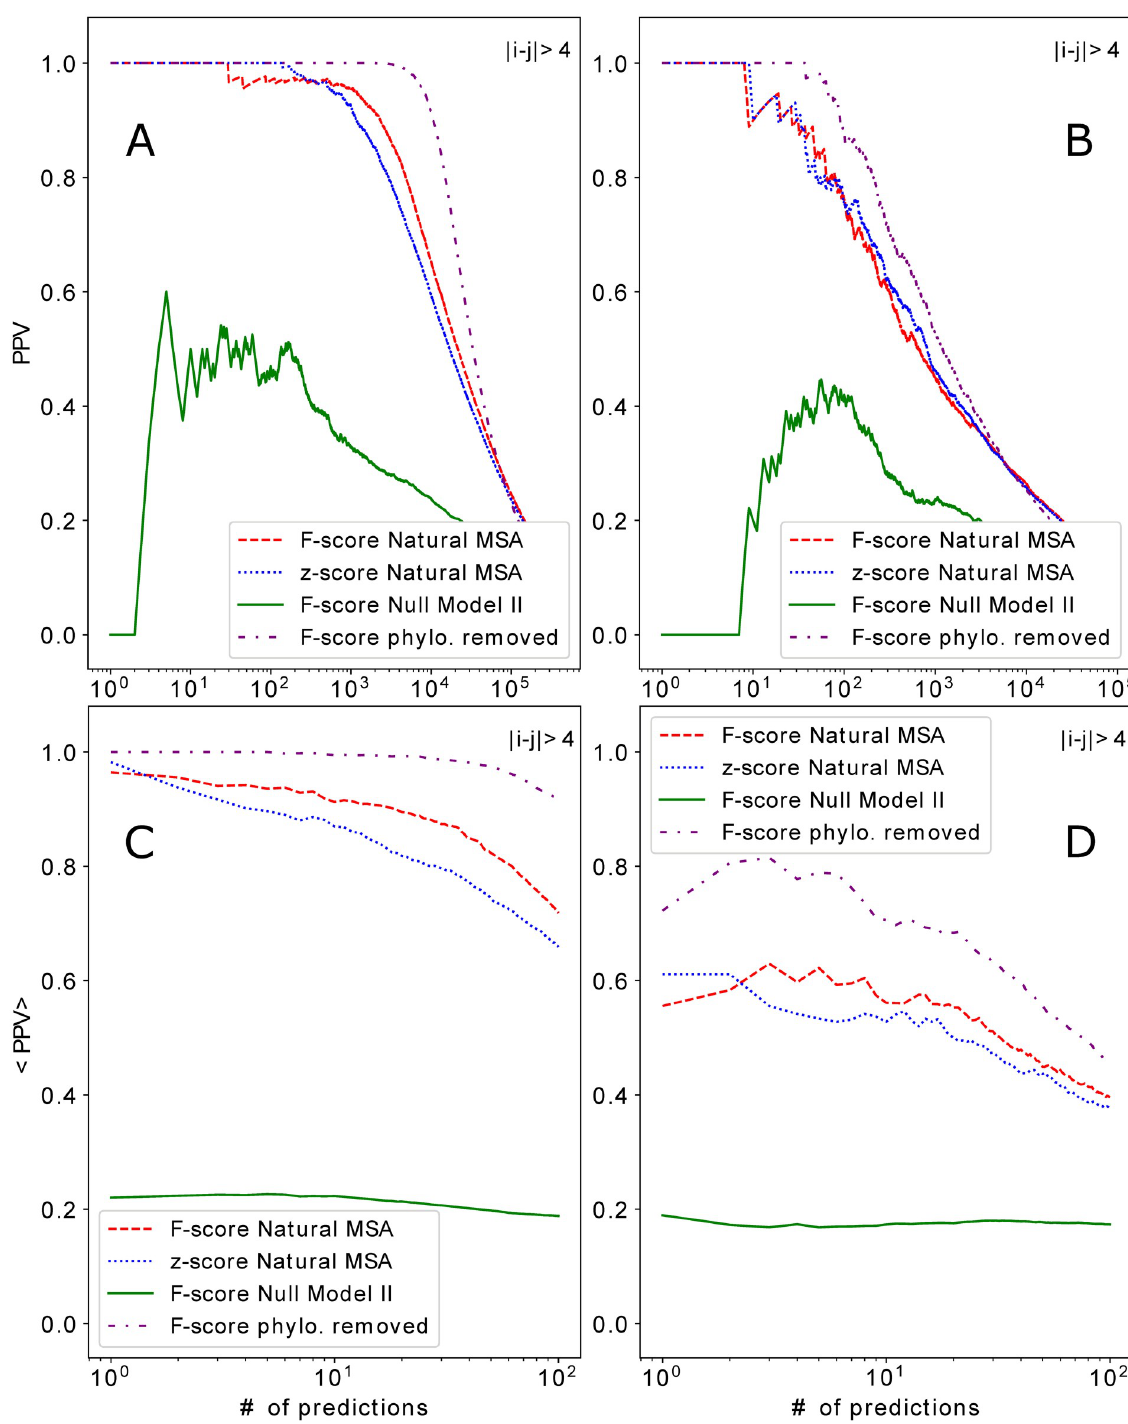
Fig 5. PPV for residue-residue contact prediction from natural data and Null model II. The positive predictive values for residue contact prediction are shown for datasets DS2 (Panels A and C) and DS3 (Panels B and D), using the natural data (red, blue) and randomized data from Null model II (green). The upper panels (A,B) show joint contact prediction for all proteins, the lower panels (C,D) the averages over the individual PPV curves for all single families. All panels show also hypothetical PPV curves (purple), which might be reached by a method removing phylogenetic biases; they articficially combine DCA scores obtained from natural MSA on contacts, and from Null model I on non- contacts.